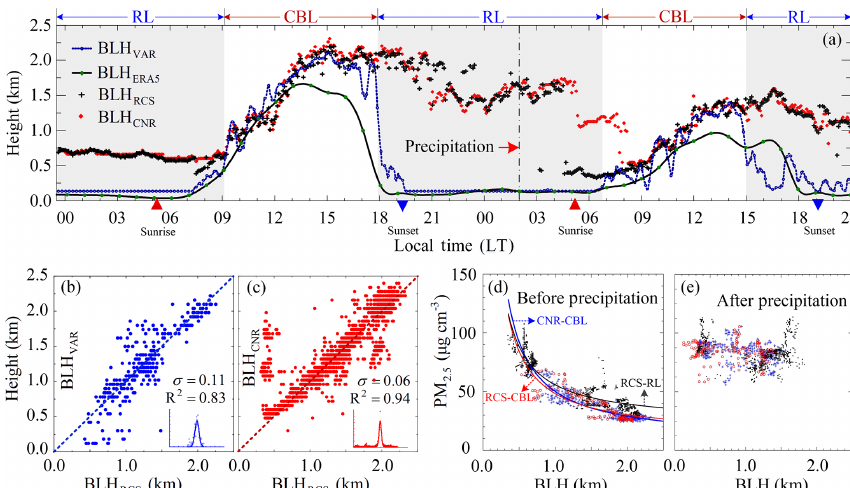
Figure 5. (a) The BLH retrieval results from different methods. Scatter plots of (b) BLH VAR in CBL and (c) BLH CNR in CBL and RL versus BLH RCS for comparison. The dashed blue and dashed red lines indicate x = y . The BLH differences are plotted in right bottom in (b) and (c) . The blue and red solid lines represent the corresponding Gauss fitting. R 2 represents the coefficient of determination and σ represents the standard deviation of Gauss fitting. (d) The scatter plot of BLH and PM 2 . 5 before precipitation. Red circles indicate BLH VAR in CBL, while blue plus signs indicate BLH RCS in CBL and black dots indicate BLH RCS in RL. The solid lines represent the corresponding inverse fit. (e) Same as (d) but without inverse fitting after